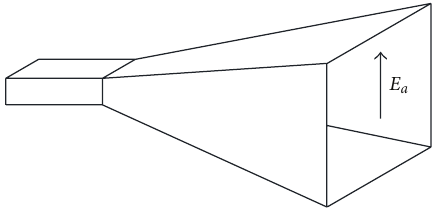
Figure 6: A typical horn antenna showing the orientation of the electrical field component of the microwave energy in the antenna’s aperture.